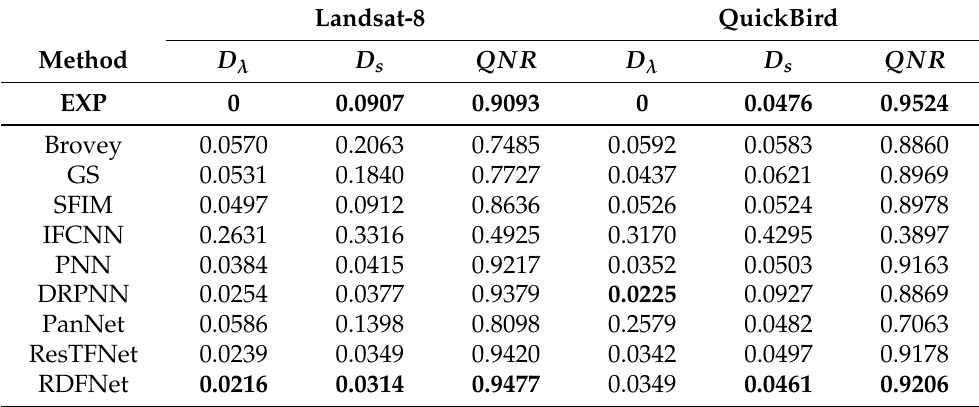
Table 2. Quantitative indicators of Landsat-8 and QuickBird fusion results with full resolution. Landsat-8 QuickBird